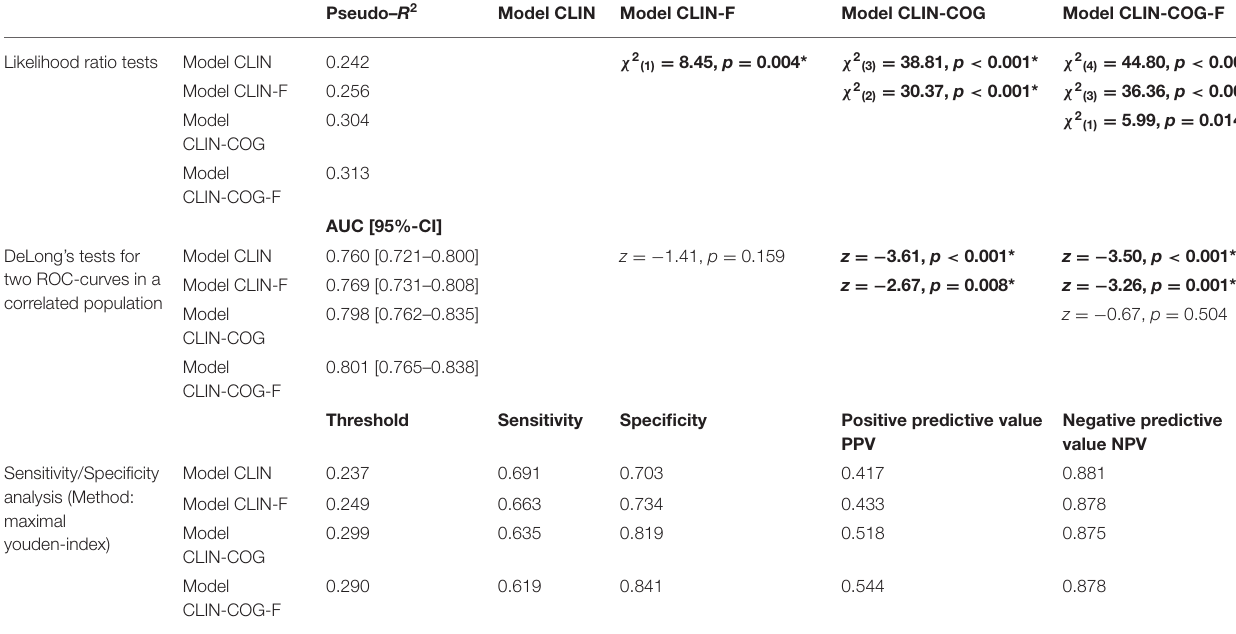
TABLE 5 | Comparison of the four